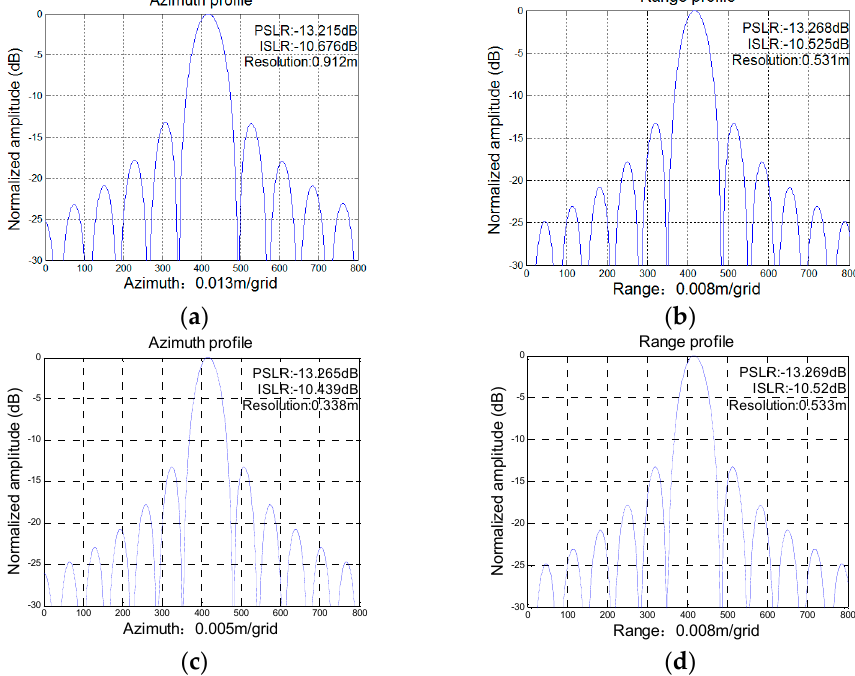
Figure 10. Profiles of the focused single target. ( a ) and ( b ) denote the azimuth and range profiles of the original stripmap data, respectively; ( c ) and ( d ) denotes the azimuth and range profiles of the stitched data, respectively.